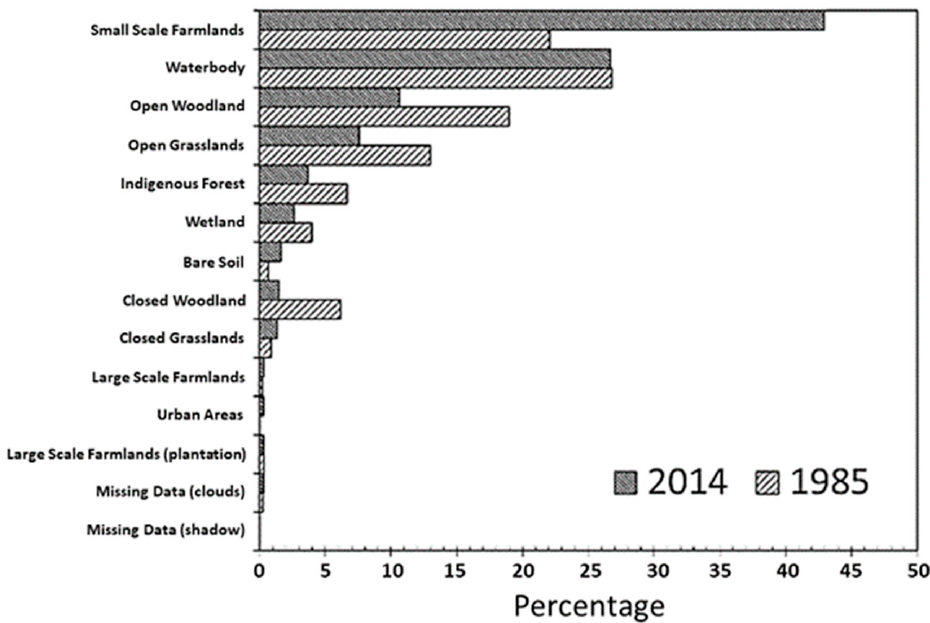
Figure 4. Proportion of each land cover class as a percentage of the total area in 1985 and 2014.